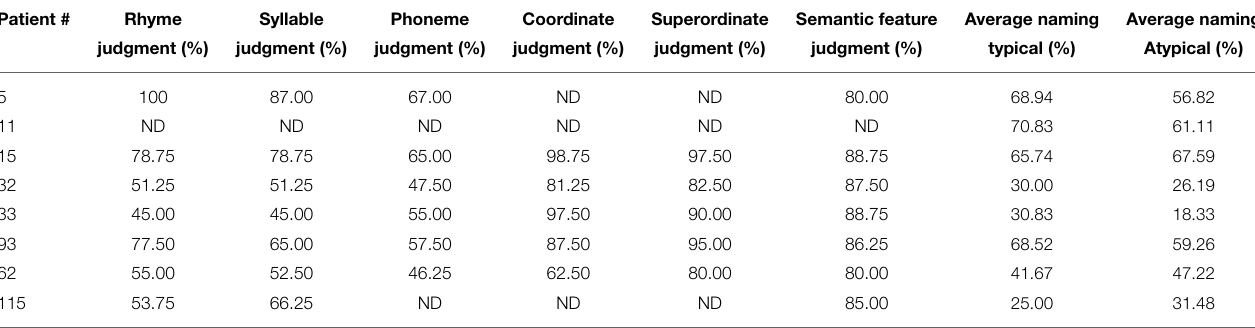
TABLE 2 | Performance on behavioral measures prior to treatment, including phonological processing tasks (rhyme judgment, syllable judgment, and phoneme judgment), semantic processing tasks (coordinate task, superordinate task, semantic feature), and picture naming (atypical and typical examples) collapsed across